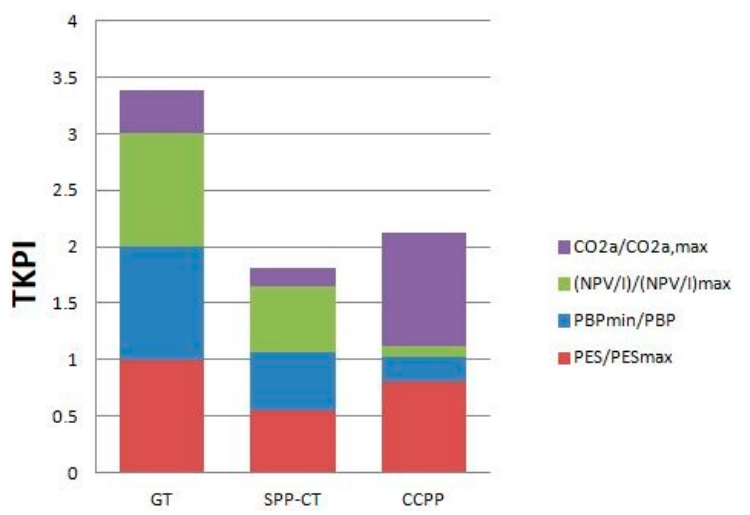
Figure 9. TKPI values and breakdown for the considered cogeneration technologies (alternative design).